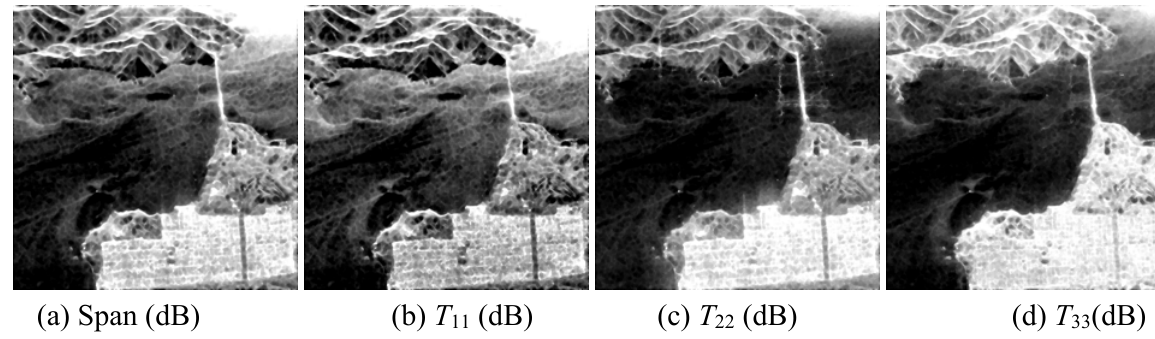
Figure 5. Basic span image and three channels image.